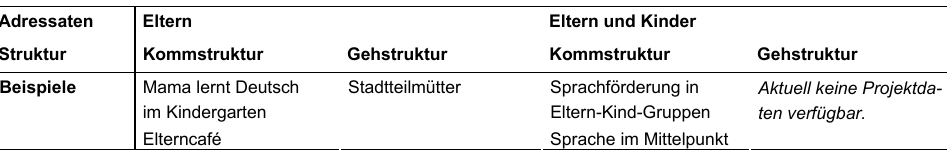
Tabelle 1 : Exemplarische monomodulare